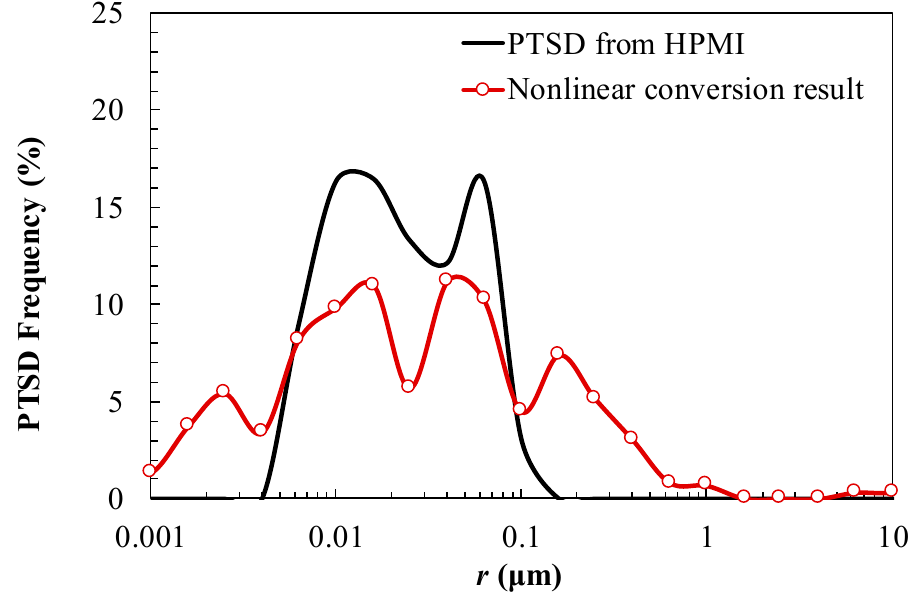
Figure 11. Comparison of the PTSD derived from HPMI with the PTSD obtained from nonlinear 230 conversion. 231